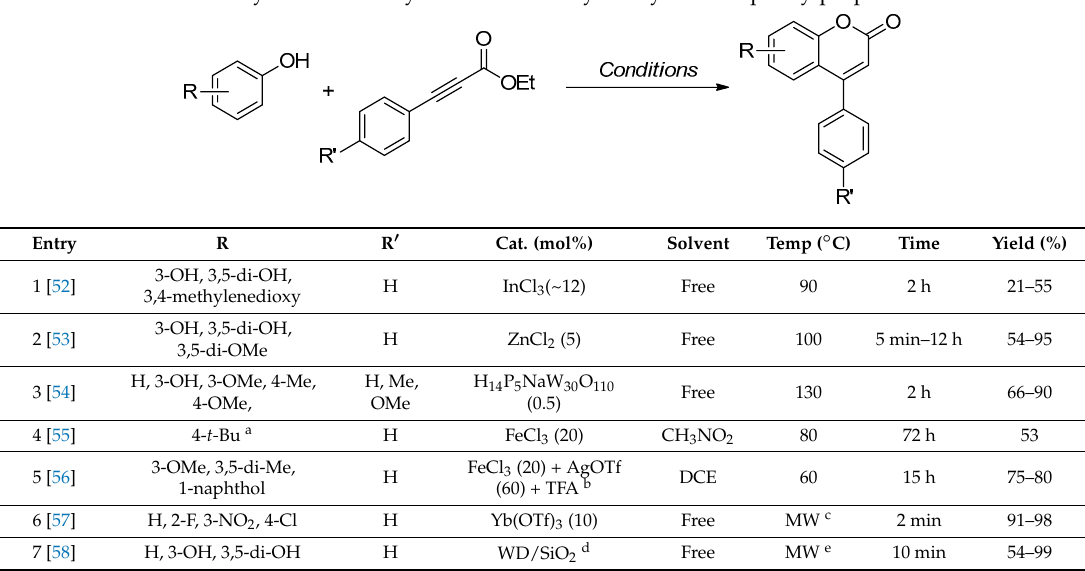
Molecules 2018 , 23 , x FOR PEER REVIEW Table 3. Synthesis of 4-arylcoumarins via hydroarylation of Table 3. Synthesis of 4-arylcoumarins via hydroarylation of phenylpropiolate.